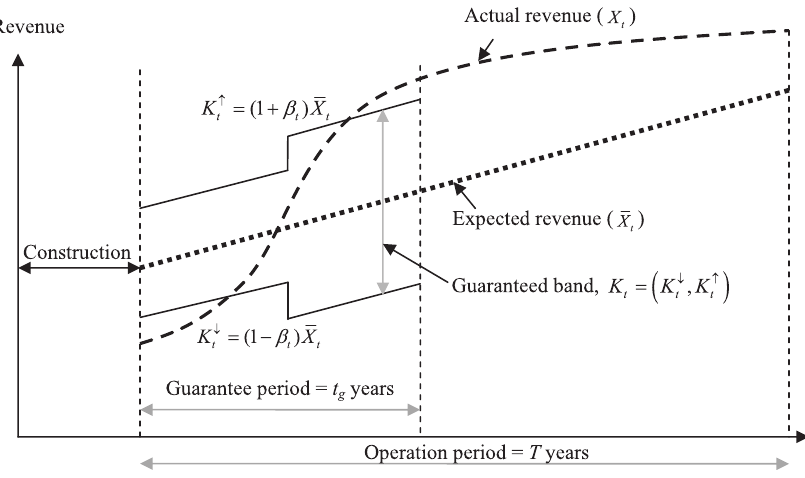
Fig. 1. Modeling of a new banded government revenue